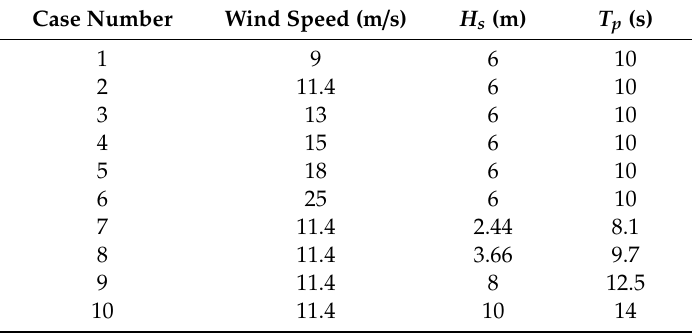
Table 10. Environmental conditions for coupled dynamics